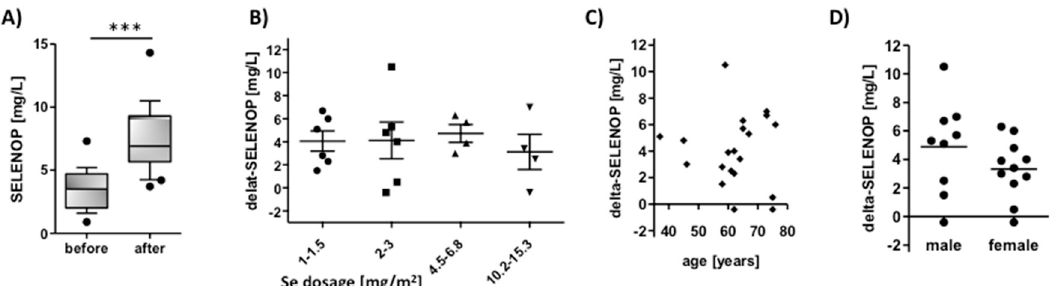
Figure 3. Increase of Se status biomarkers after four days of selenite infusions in the SECAR trial in relation to time, dosage, age, and sex. Cancer patients received different amounts of Se (i.v.) daily, ranging from 1 to 33.4 mg selenite/m 2 . ( A ) SELENOP concentrations increased strongly from baseline on day 1 (before) to day 5 (after) daily infusions. Incremental SELENOP increase was independent of